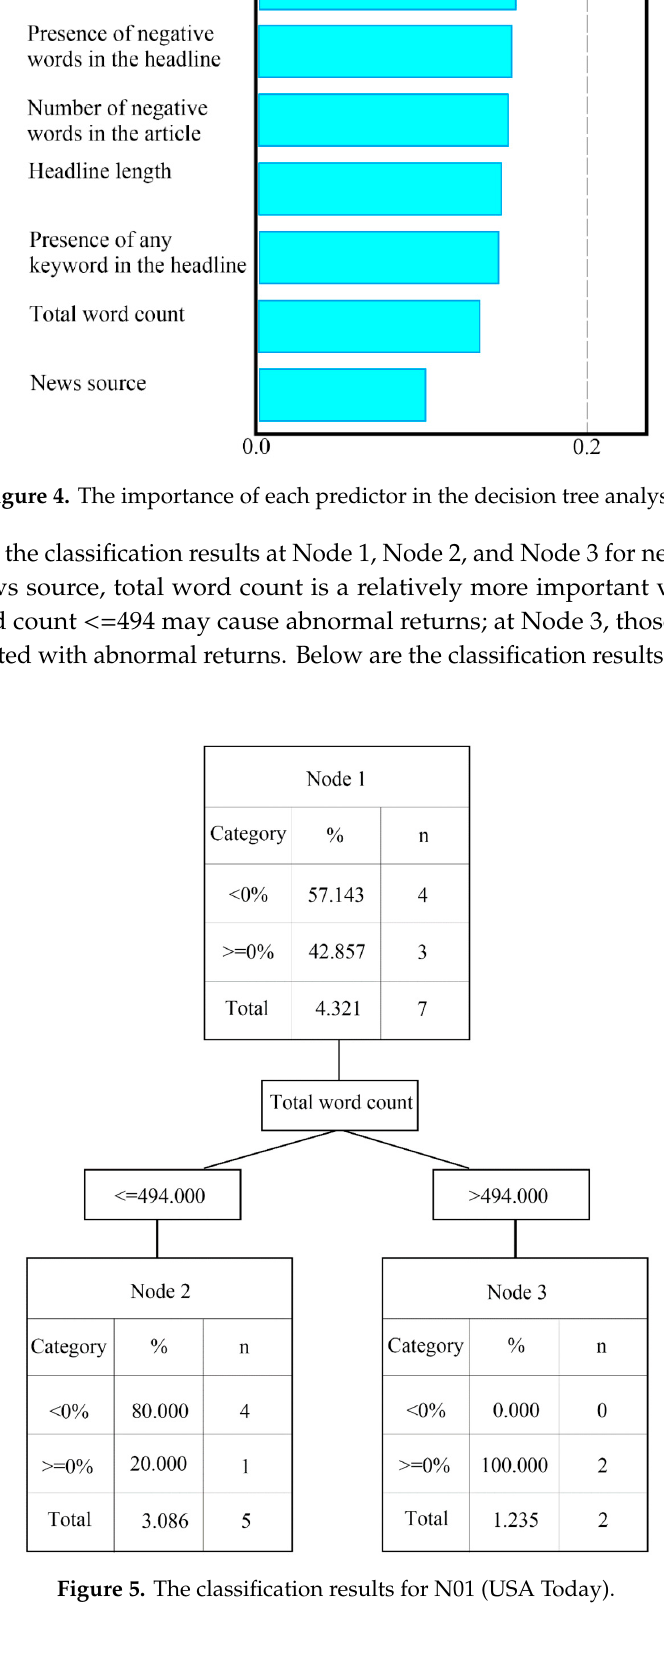
12 Table 9. The classification result for Node 0 in the decision tree.